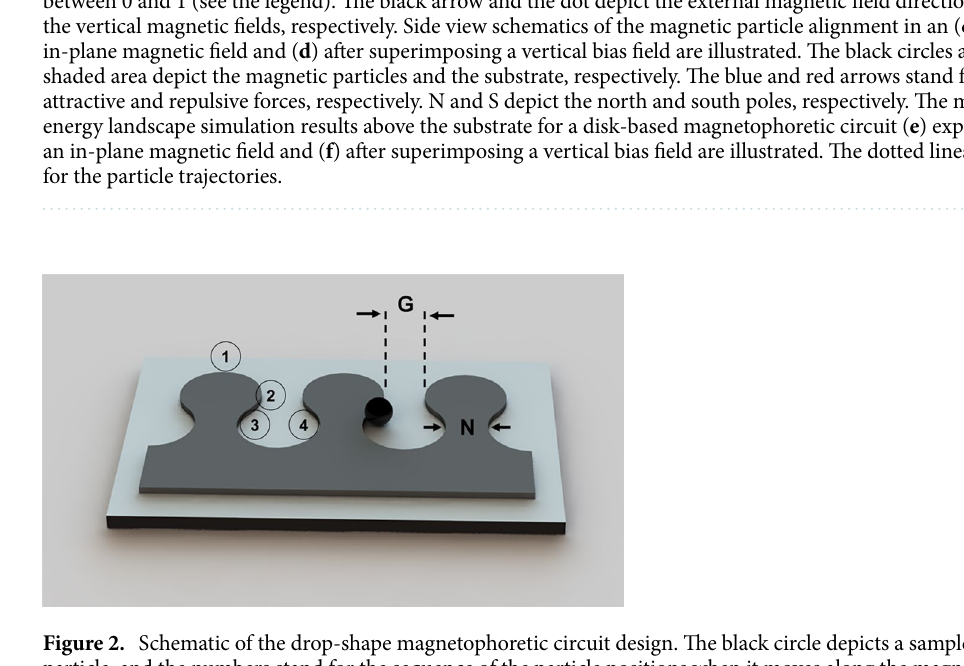
Figure 2. Schematic of the drop-shape magnetophoretic circuit design. The black circle depicts a sample particle, and the numbers stand for the sequence of the particle positions when it moves along the magnetic track. In our fabricated chips, G is 15